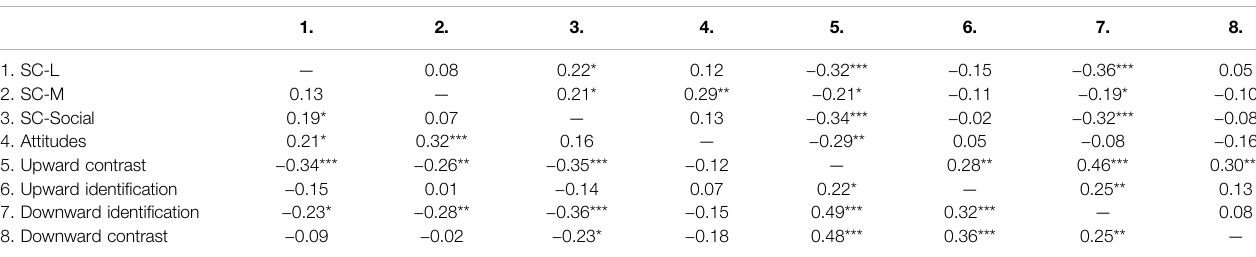
TABLE 2 | Correlations between the variables of interest for girls (below the diagonal) and boys (above the